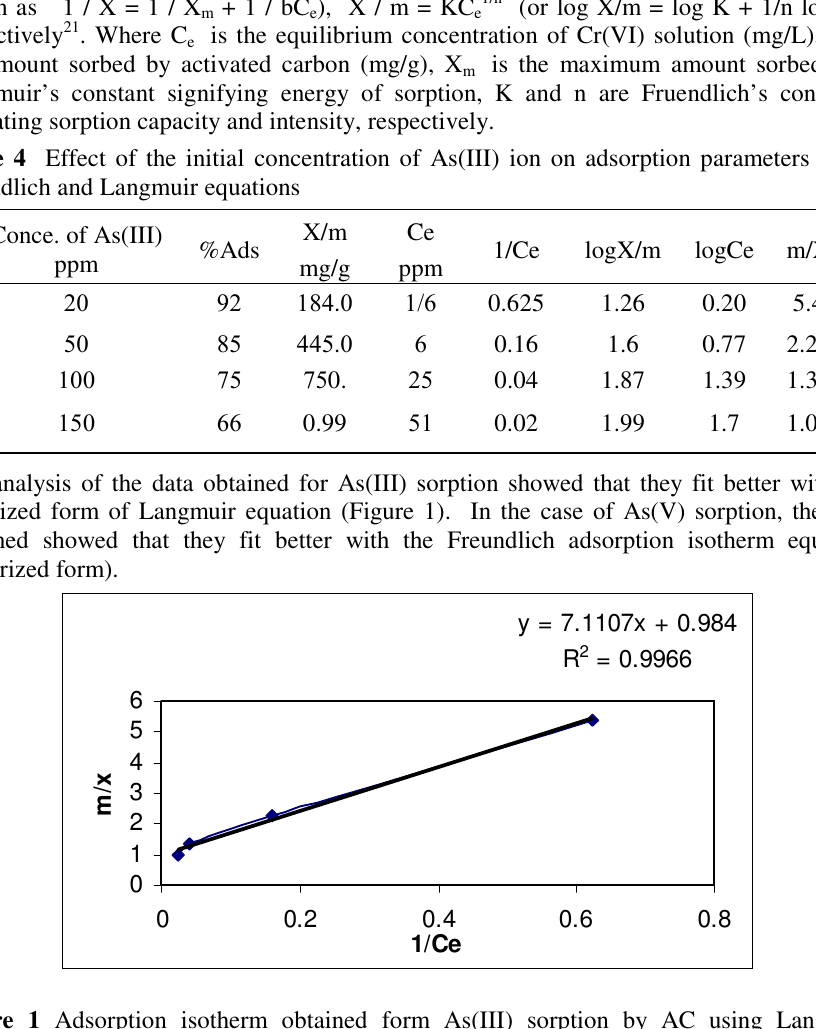
Table 3 Effect of initial As(III) ion concentration on sorption using (cid:1) activated carbon Concentration ppm 10 20 50 100 150 % Sorption , As(III) 95 92 85 75 66 pH=12 % Sorption , As(V) 84 75 60 45 30 pH= 3